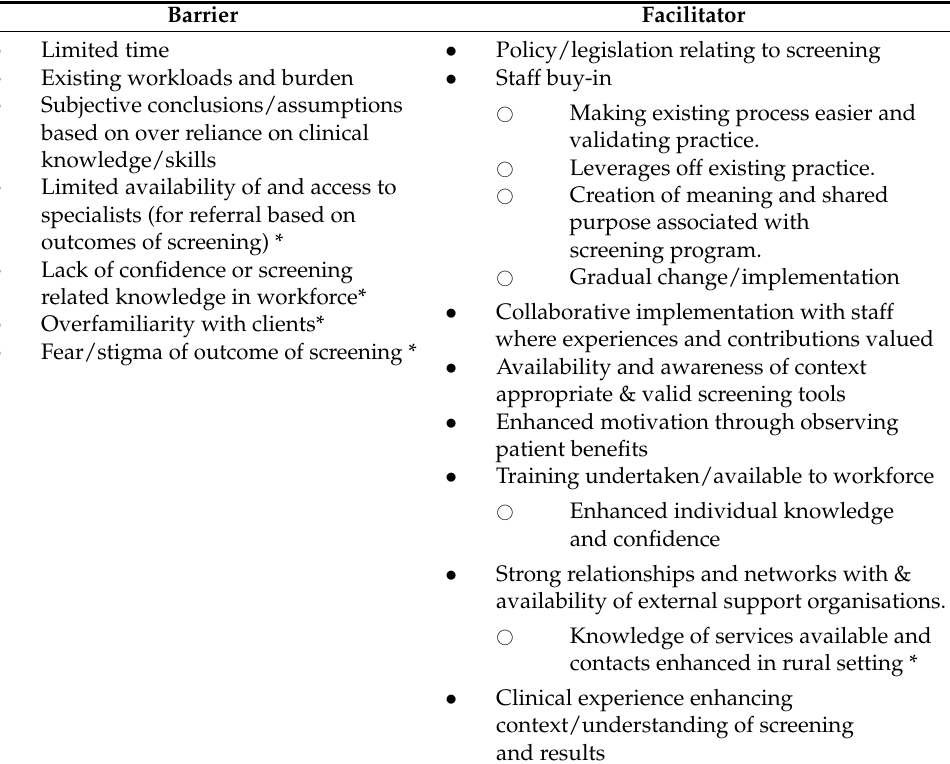
Table 4. Summary of barriers and facilitators to cognitive screening as identified in two rural healthcare